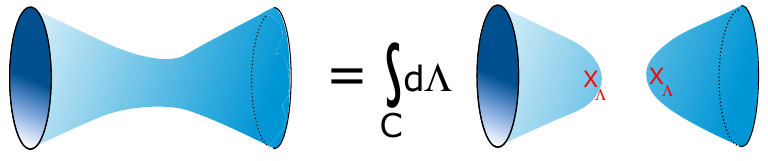
Figure 14 . Left: annulus amplitude in compact BF theory. The description in terms of two par- ticle on group models contains a common G -gauge symmetry, acting diagonally on both boundary actions. Right: schematic decomposition in terms of twisted partition functions, glued together by integrating over Λ C ∈